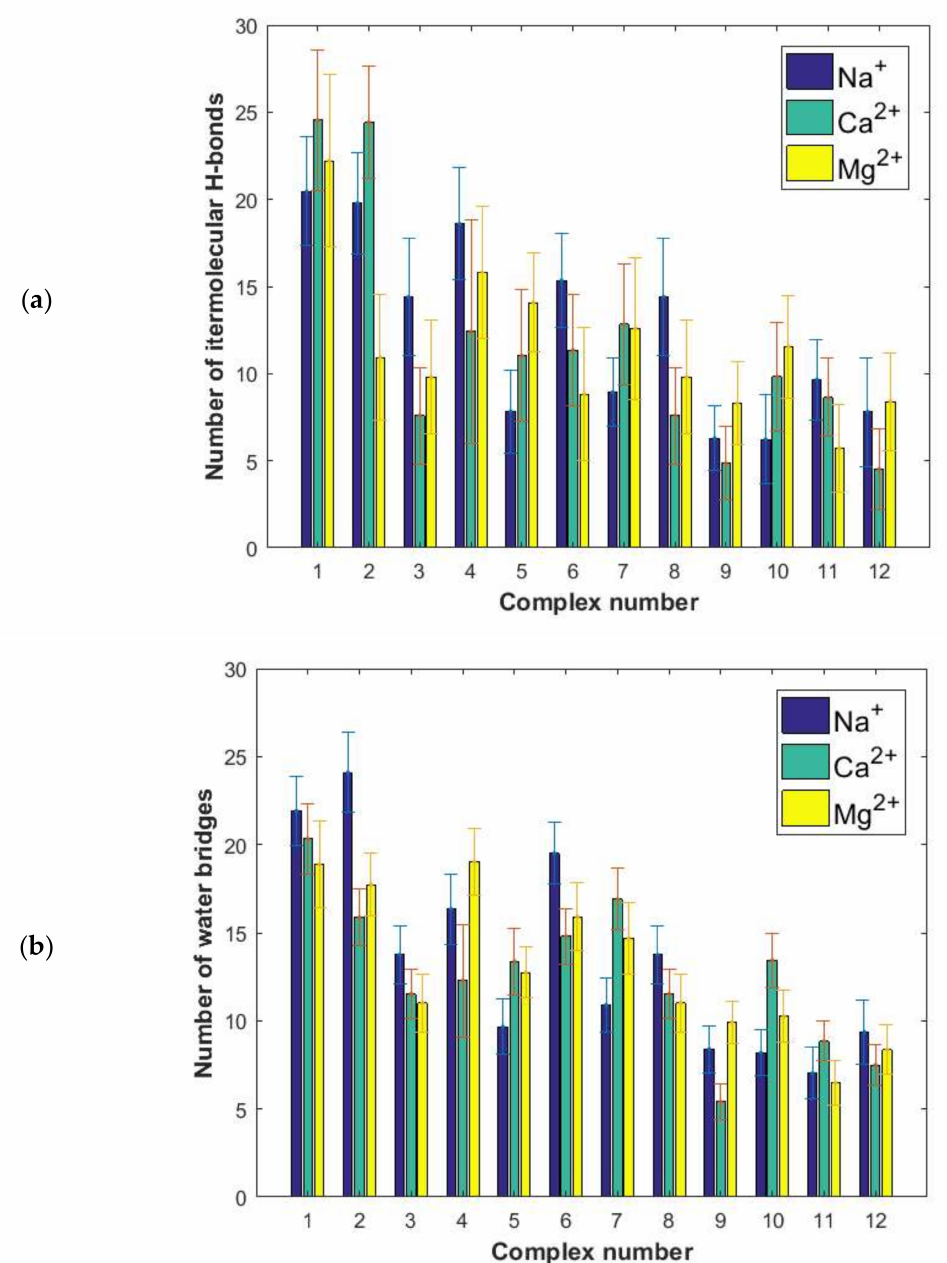
Figure 5. ( a ) Number of direct intermolecular H-bonds. ( b ) Water bridges between HSA and HA for different complexes evaluated by